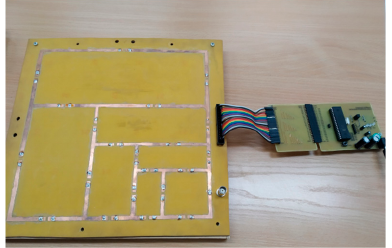
Figure 5. A prototype of antenna template with microcontroller.